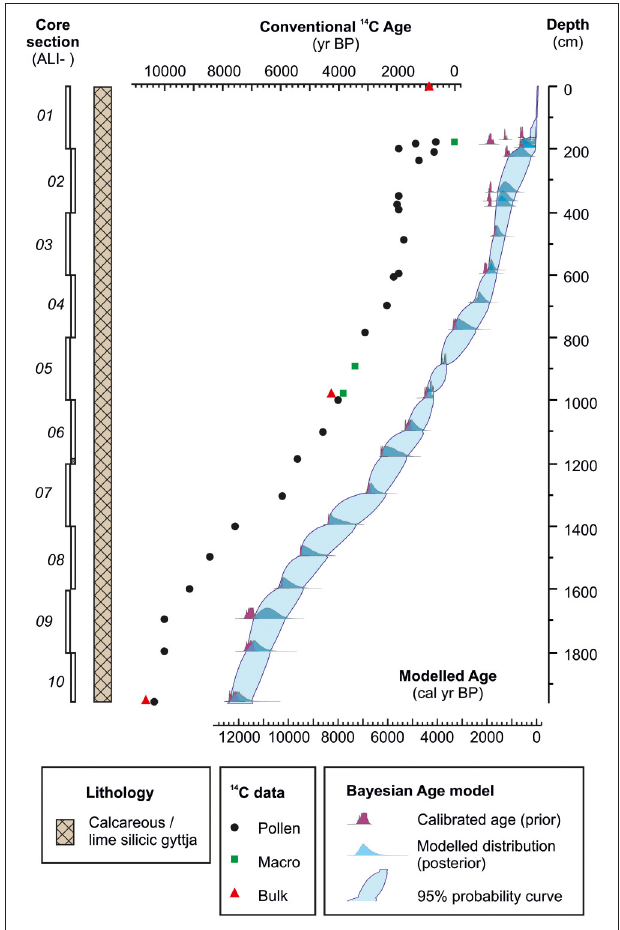
FIGURE 5 | Core sequence ALI 01-10, lithology, radiocarbon control points and Bayesian deposition model for Lake Sidi Ali (full details of the age model in Fletcher et al.,